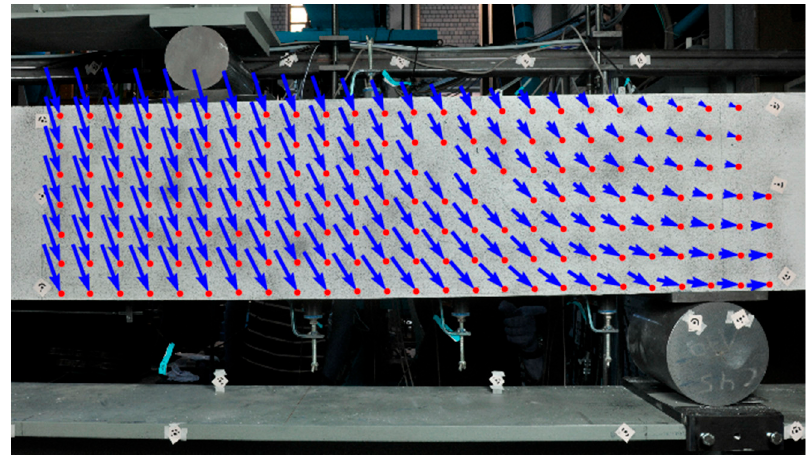
Figure 1. Displacement field, exaggerated using a vector scale factor of 6, from a bend test.